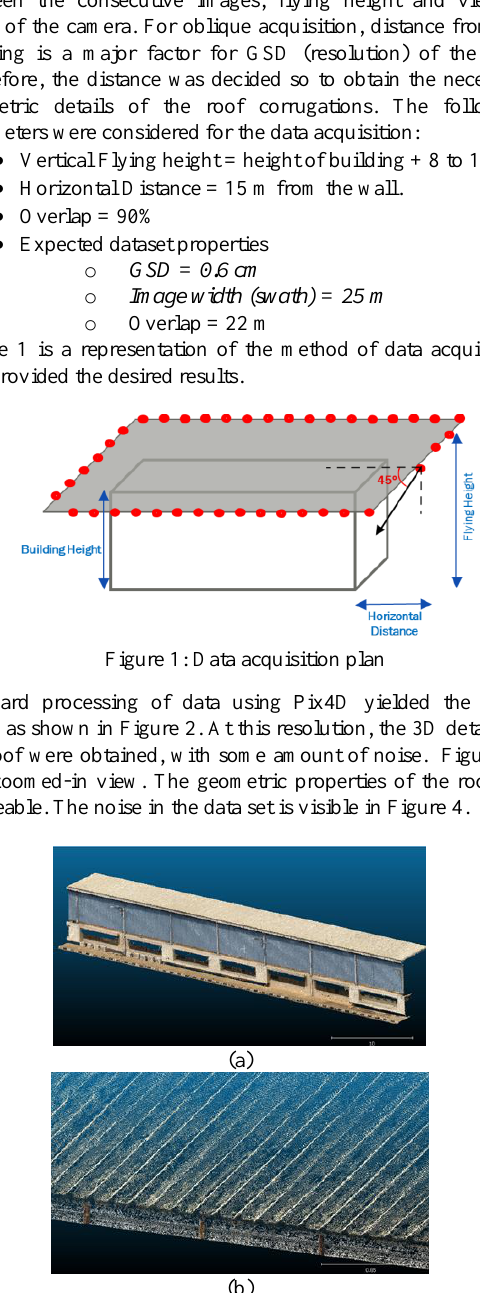
Figure 2: Output point cloud; a) Location, b) Magnified section